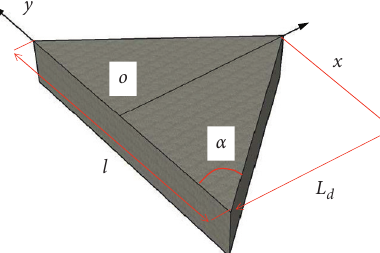
Figure 1: Mechanical model of key block B in roadway retaining.